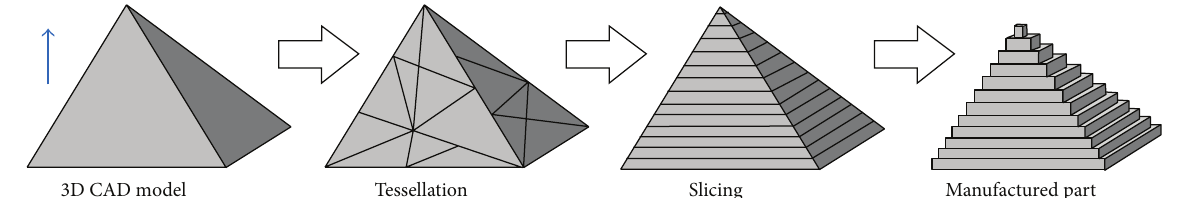
Figure 1: General AM process (blue = build